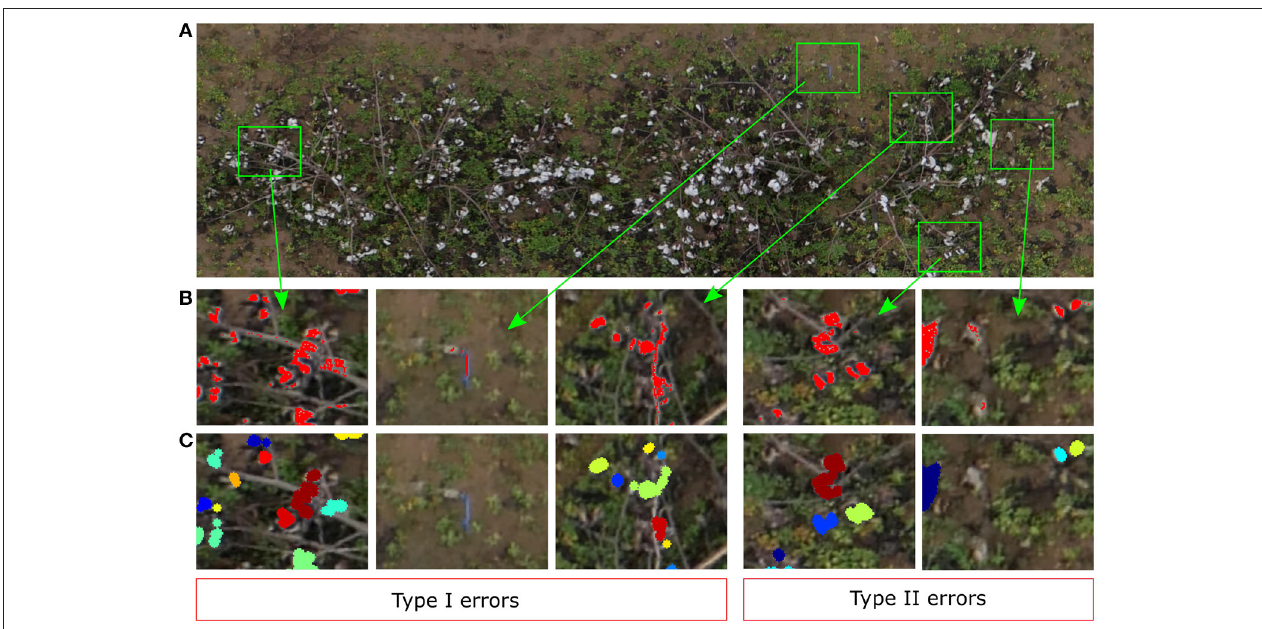
FIGURE 12 | Qualitative analysis of the yield estimator. (A) Original image plot (Plot ID 45003), (B) Zoomed-in view to Type I and Type II errors at segmenting cotton pixels. Red represents the pixels segmented by the SVM classifier as cotton pixels, (C) Zoomed-in view to the same zones as (B) to visualize the clustering results. Different colors identify different clusters (cotton